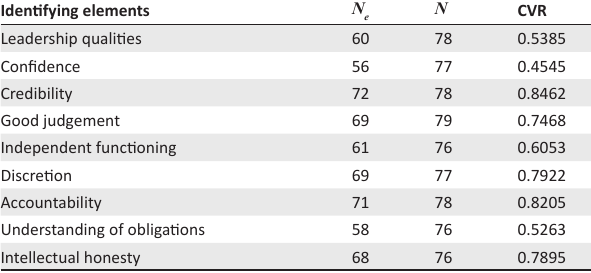
TABLE 6: Content Validity Ratio (Lawshe) of desirable professional